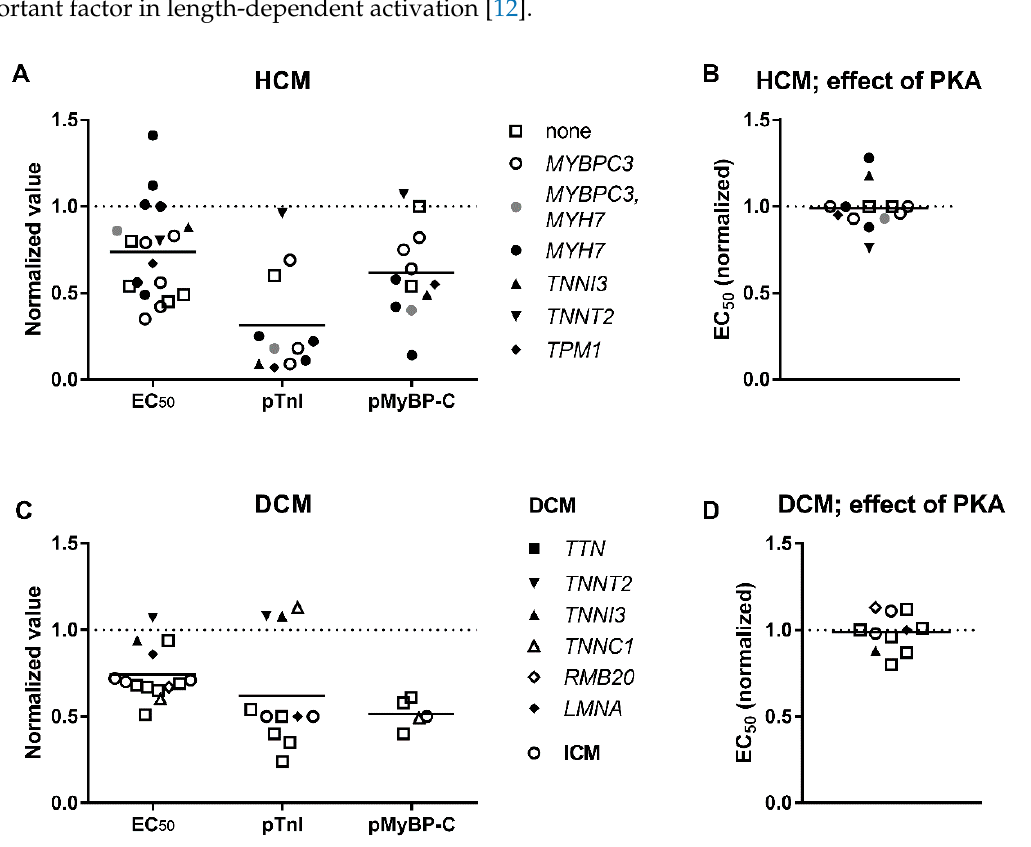
Figure 3. The concentration of Ca 2+ required for half-maximal contraction ( EC 50 ) and total phosphorylation level of troponin I (pTnI) and MyBP-C (pMyBP-C) of heart tissue samples. The data are from Tables 1 and 2. The values for HCM ( A , B ), DCM ( C , D ) are normalized to control donor hearts (dashed line). The effect of PKA treatment on Ca 2+ -sensitivity of heart muscles from HCM ( B ) and DCM ( D ) patients. The EC 50 values are normalized to the EC 50 of normal donor heart samples. PKA eliminates or at least lessens the difference between cardiomyopathic and donor hearts. Each data point represents a different experimental group where the symbols indicate genes where mutations were